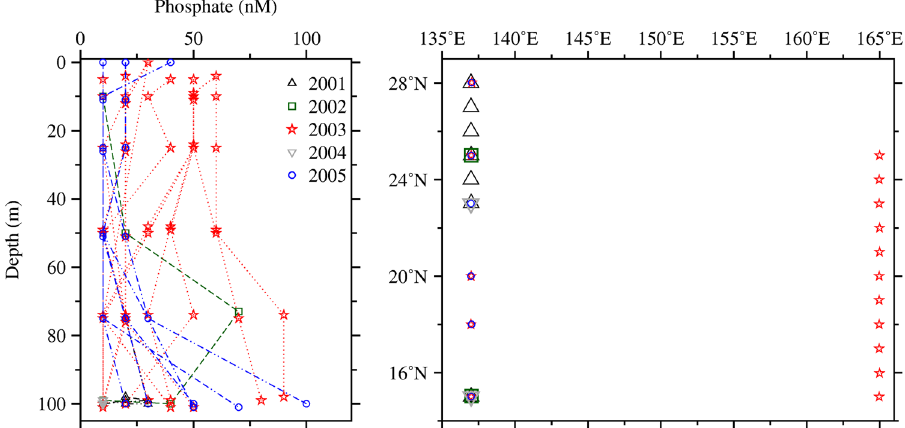
Figure 7. Vertical profiles of phosphate concentrations measured during the month of July by Japan Meteorological Agency from 2001 to 2005 within the region 15–28°N and 135–165°E (left), with corresponding locations (right).